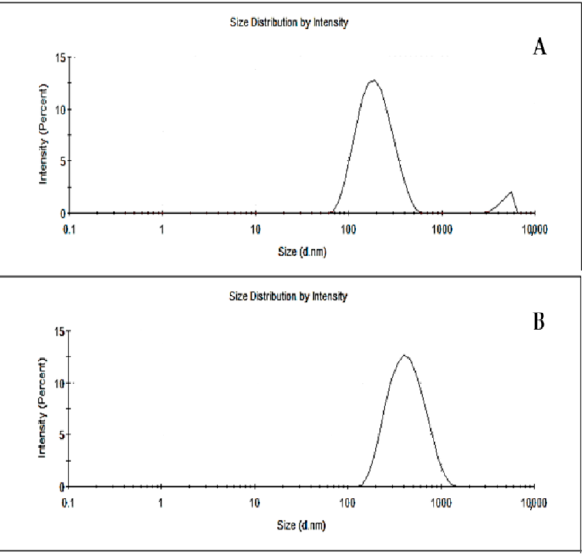
Figure 3. Particle size distribution; ( A ) NPs (nanoparticles without propolis), ( B ) NPRP (nanopar- ticles loaded with red